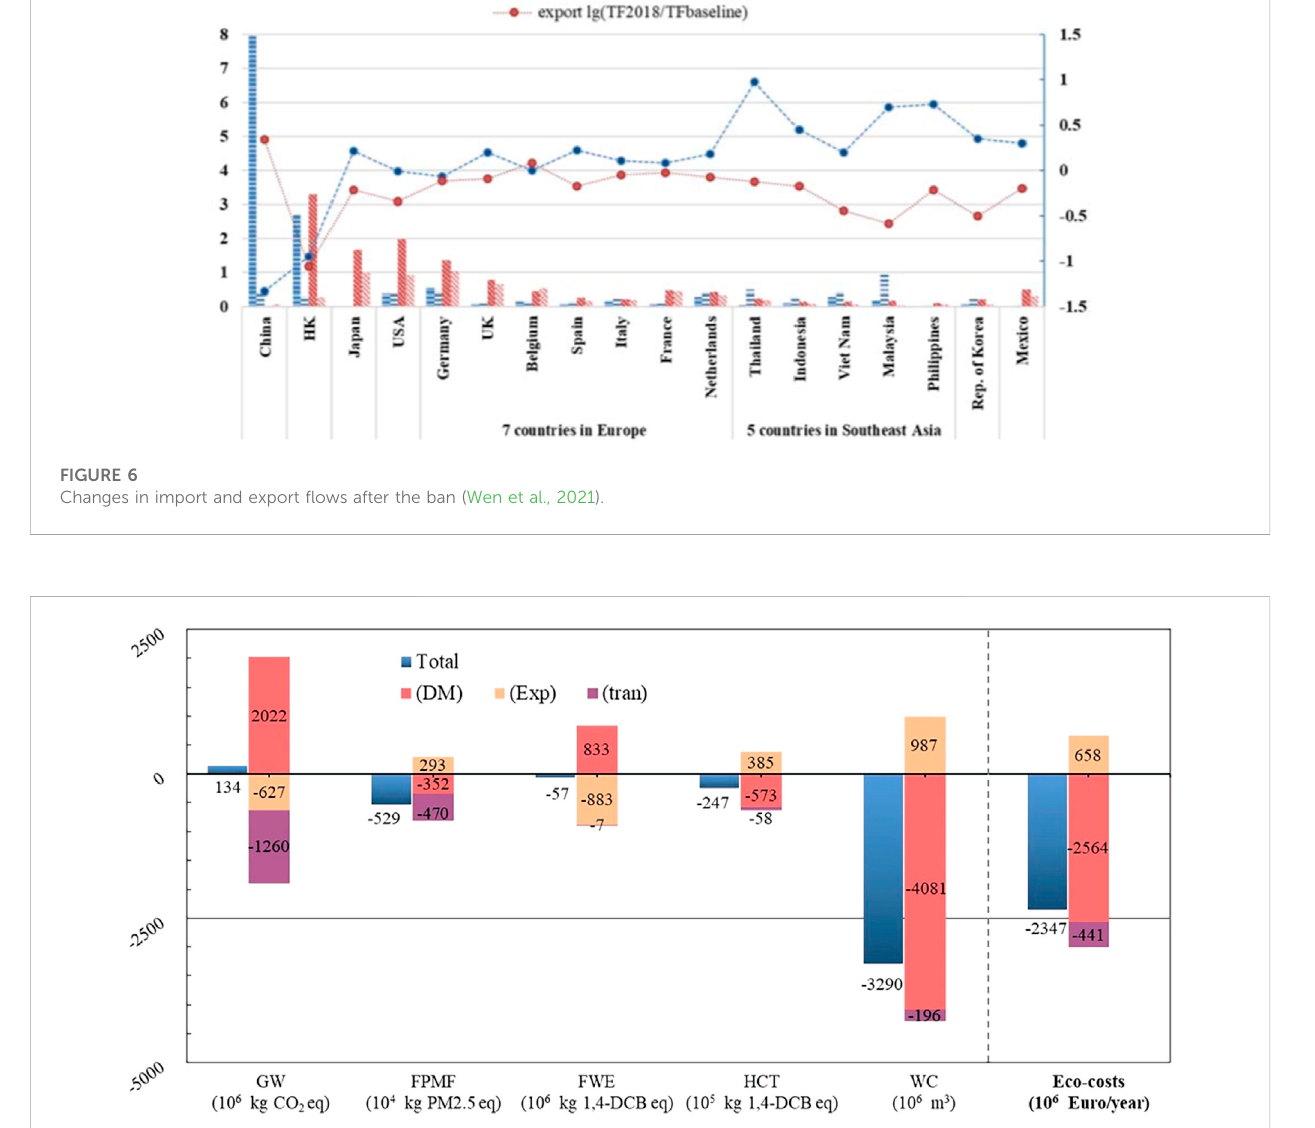
FIGURE 7 EIT and eco-cost of the China ban for the 2018 Scenario. Note that an item has a bene fi cial environmental impact when its value is negative. To enhance the visibility of midpoint indicator values on the ordinate axis, the unit of each indicator was adjusted as shown in the brackets at the bottom of the fi gure (Wen et al.,